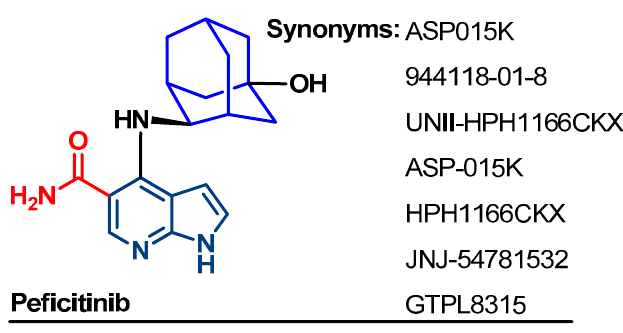
Figure 43. Chemical structure/name/synonyms of peficitinib.